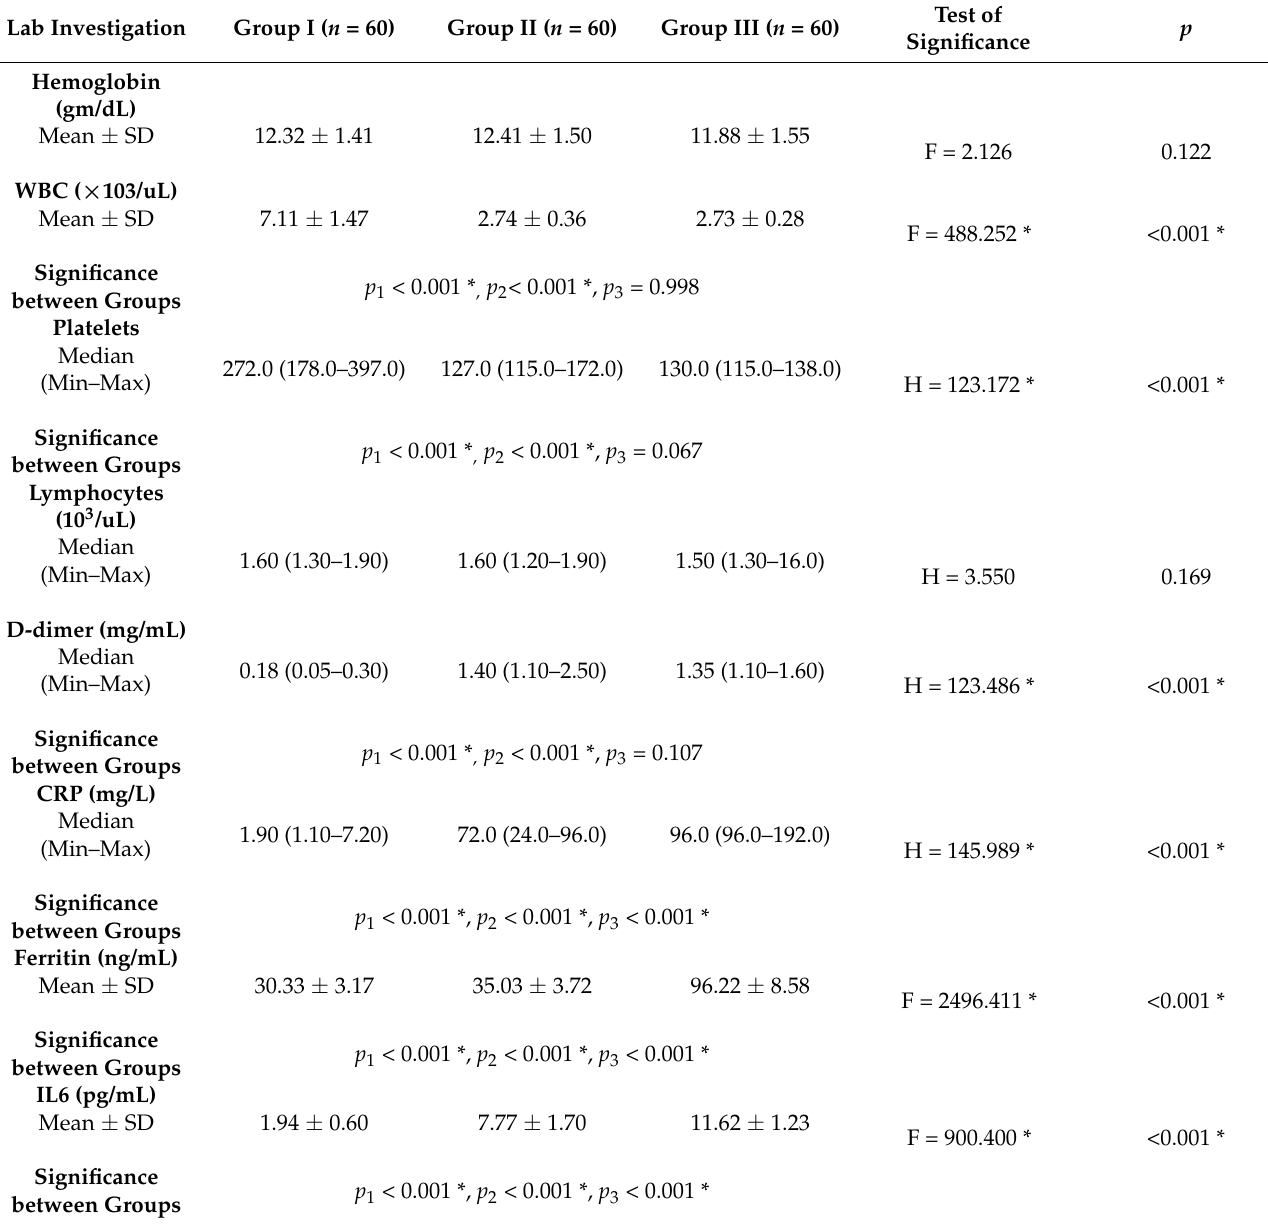
Table 1. Comparison between the three studied groups according to the lab